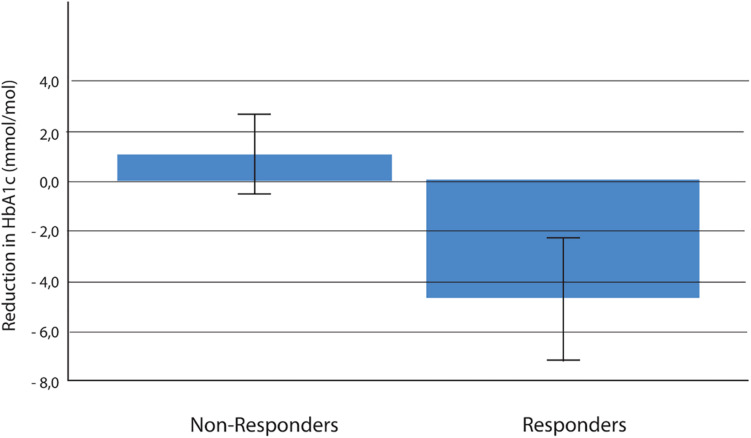
Reduction in HbA1c (mmol/mol) over 6 months among responders (a decrease in PPS ≥ 15 arbitrary units) versus non-responders (a decrease in PPS less than 15 arbitrary units); (active and control group together) mean ± SE; p < 0.001 (n = 52 in responder group and n = 60 in non-responder group). HbA1c, glycated hemoglobin; PPS, pressure pain sensitivity.